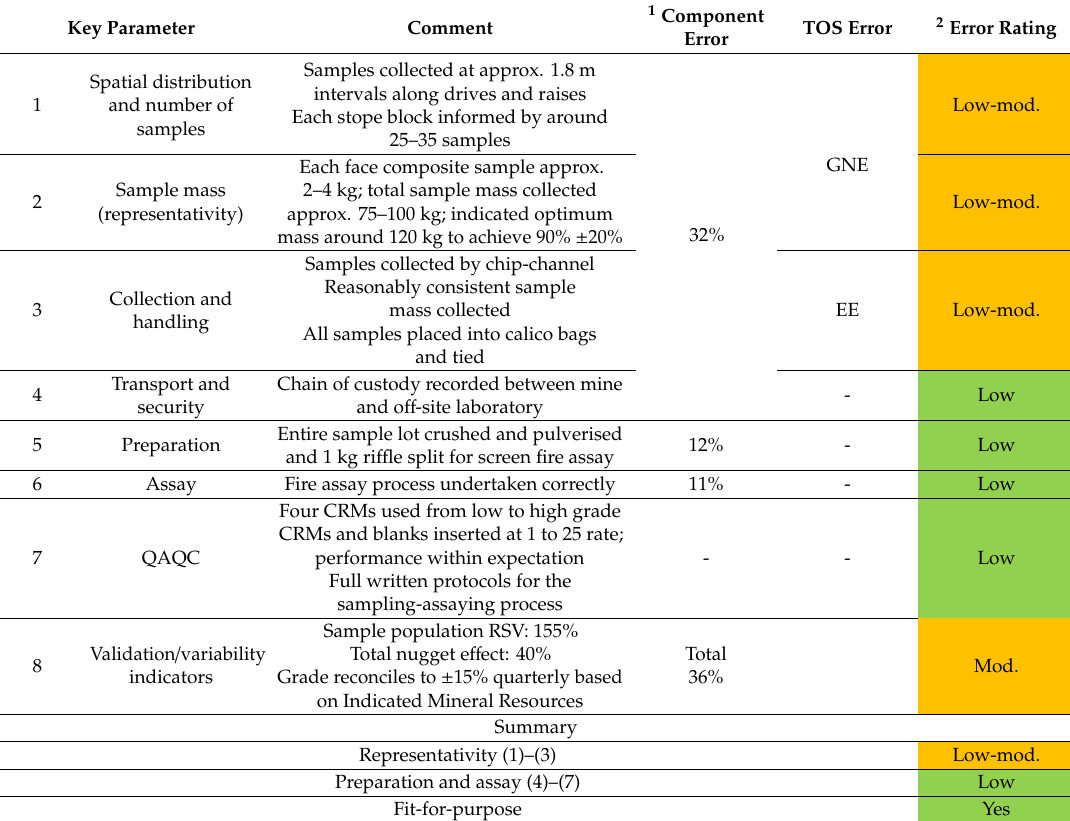
Table 3. Risk review for a low-coarse gold mineralisation grade control sampling programme used for resource